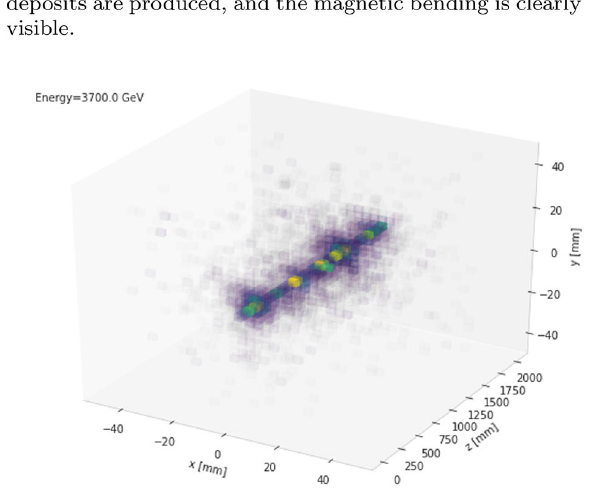
muon samples, for a total of 429 750 muons, are generated at fixed values of muon energy (E = 100, 500, 900, 1300, 1700, 2100, 2500, 2900, 3300, 3700, 4100 GeV) in order to verify the posterior distributions in additional tests discussed infra , Sect. 4. Such a discrete-energy dataset allows us to compute precisely the resolution of the trained regressor at specific muon energies, rather than having to bin muons according to their